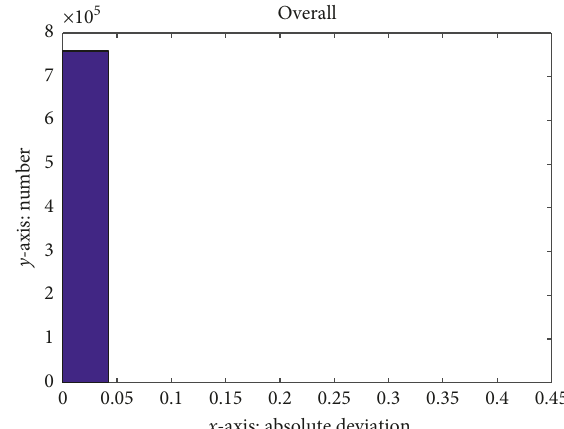
AT method (the black dots Figure 9: Histogram of distribution of the absolute deviations of the c values.